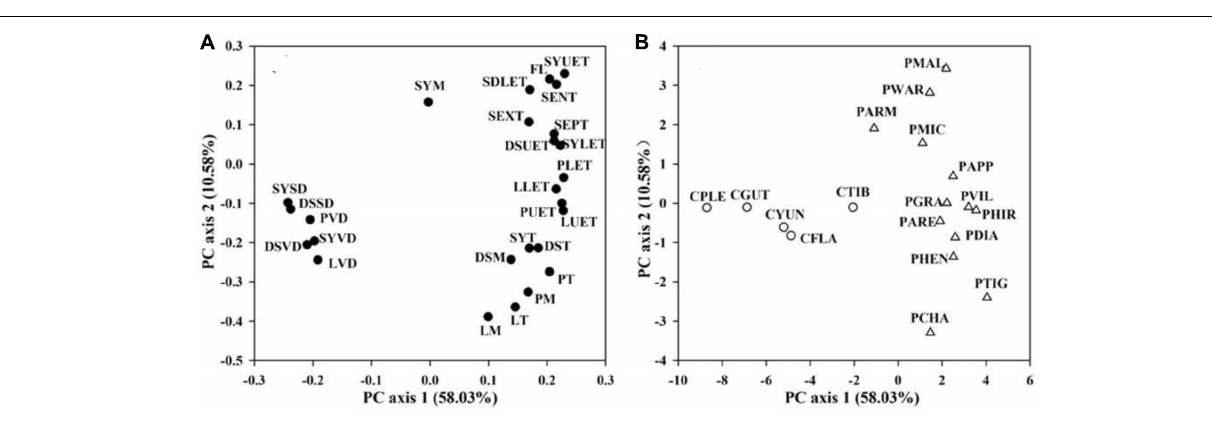
FIGURE 3 | Principal component analysis (PCA) based on 26 floral traits (A) from 28 slipper orchids. PCA axes are presented in (B) . Values in parentheses along each axis indicate percentages of explained variation. Abbreviations for traits and species are shown in Table 1 and Supplementary Table 1 ,